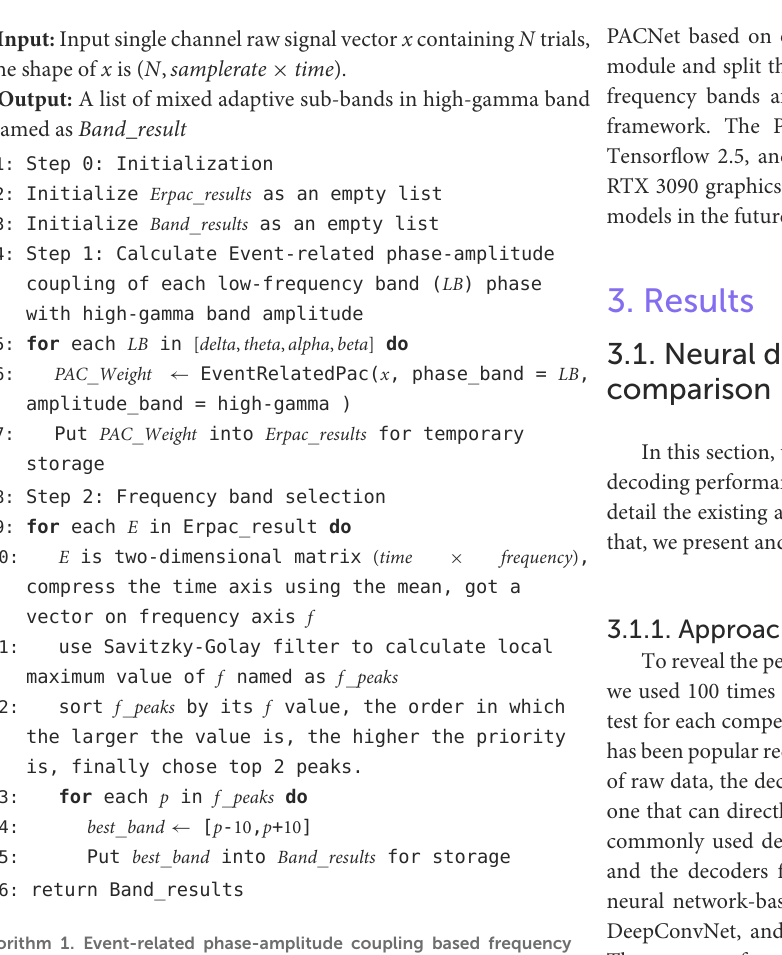
Algorithm 1. Event-related phase-amplitude coupling based frequency band